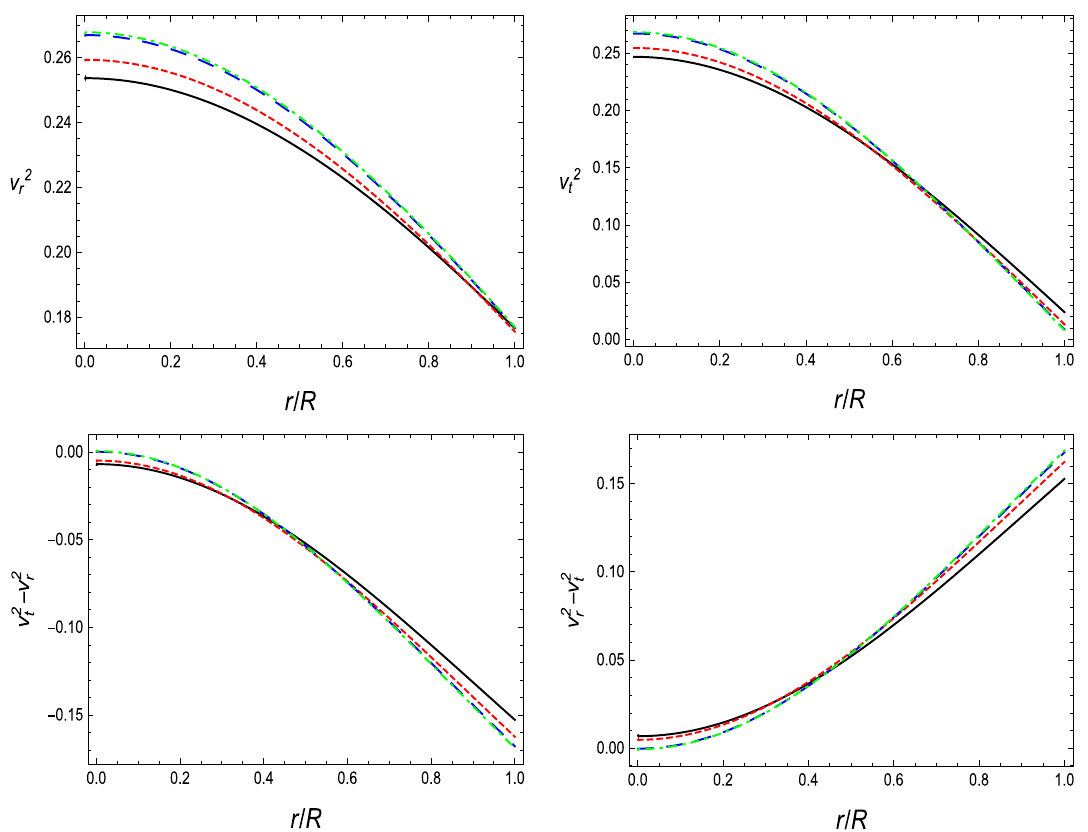
Fig. 6 Profiles of sound speeds v 2 sr , v 2 st and causality condition v 2 sr − v 2 st and v 2 st − v 2 sr versus radial coordinate, r . The same set of numerical values has been used to plot these graphs as mentioned in